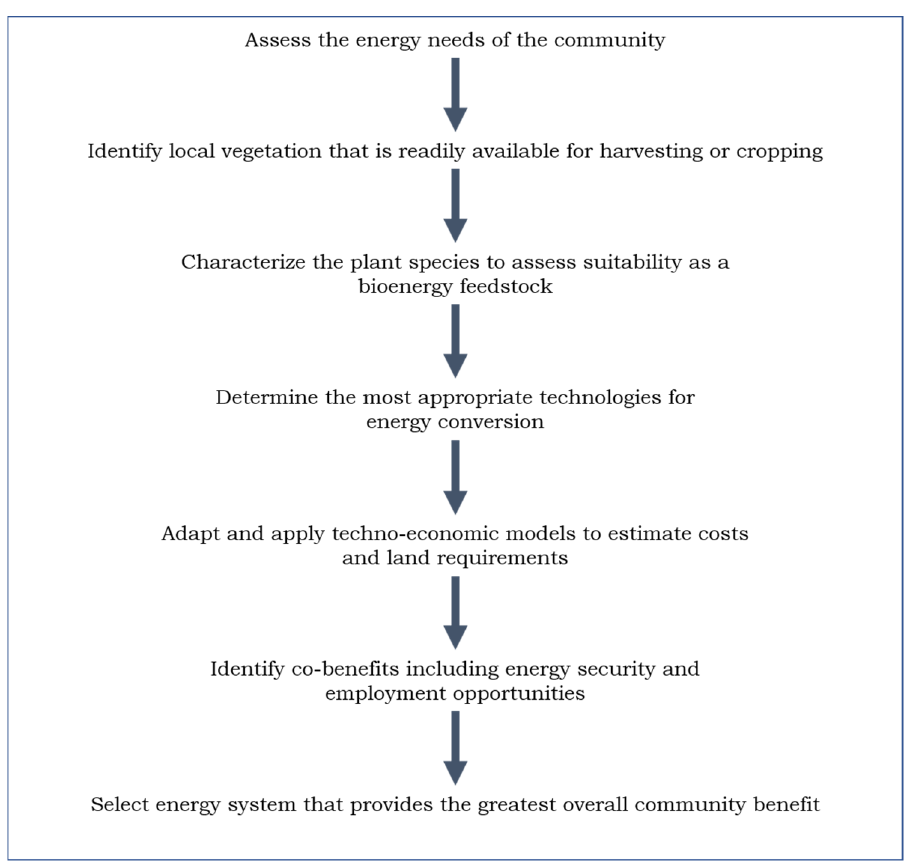
Figure 2. Framework used to determine the feasibility of using bioenergy to supply electricity to the Tiwi Islands, the requirements of such a system, and the benefits .